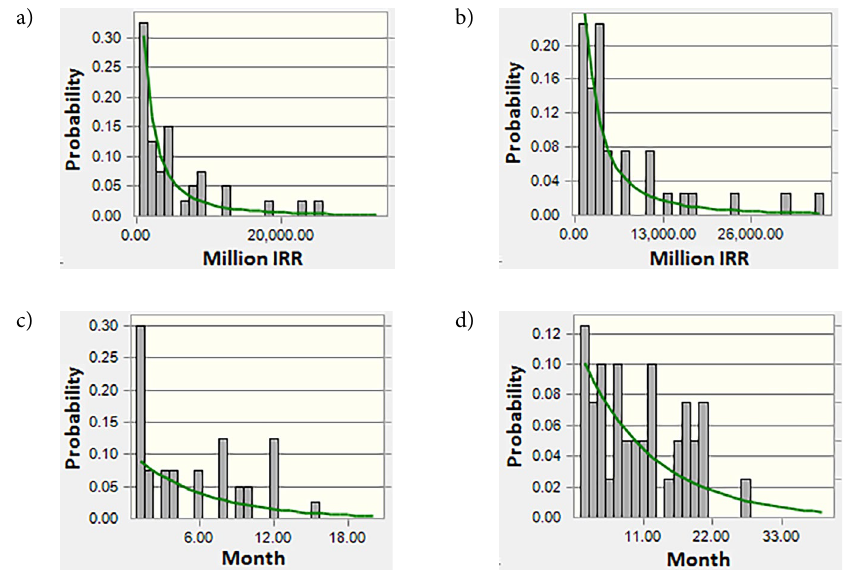
Figure 6. The best fit probability distributions for actual and contract cost and time: a – Best fit distribution for contract cost, lognormal with m = 8507.17, s = 2496 and g = 325.99; b – Best fit distribution for actual cost, lognormal with m = 8972.48, s = 2173 and g = 325.02; c – Best fit distribution for contract completion time, exponential with l = 0.17; d – Best fit distribution for actual completion time, exponential with l =